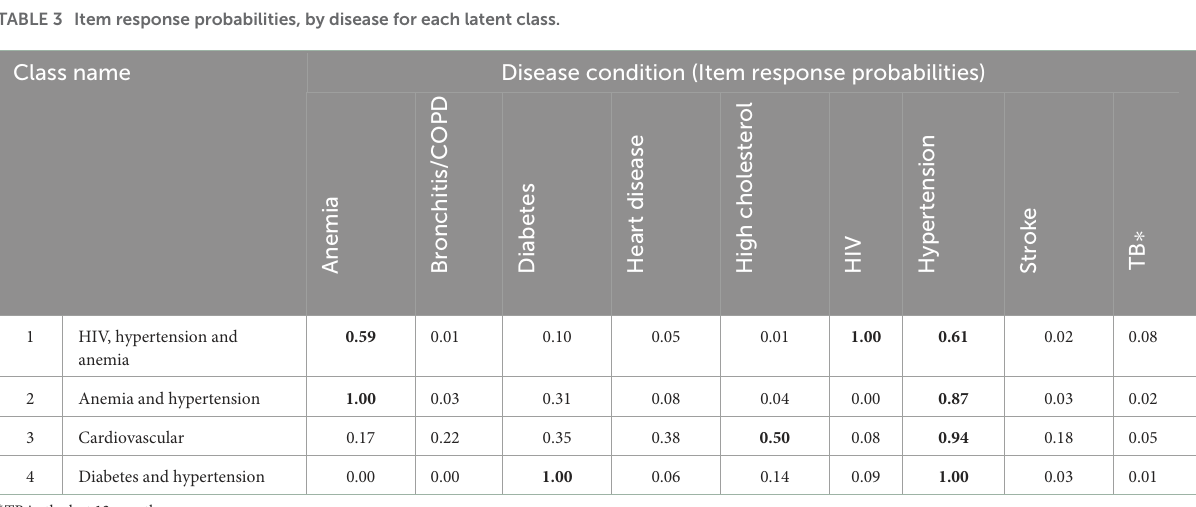
TABLE 3 Item response probabilities, by disease for each latent